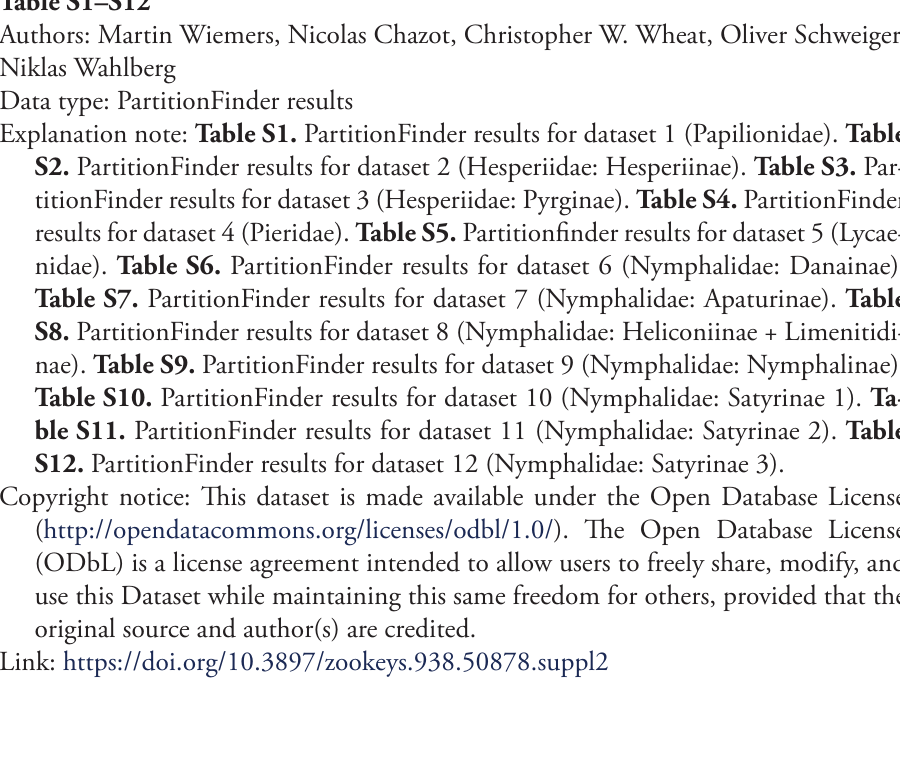
Explanation note: Table S1. PartitionFinder results for dataset 1 (Papilionidae). Table